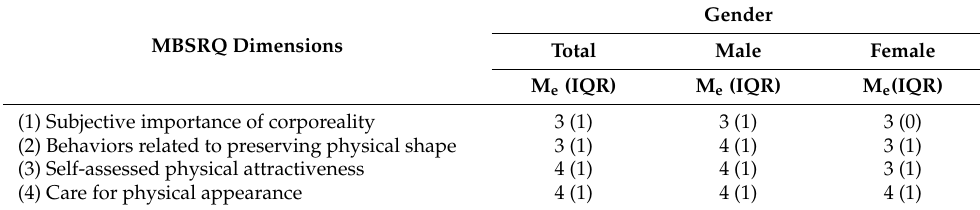
Table 2. Descriptive statistics by sex of the MBSRQ dimensions.